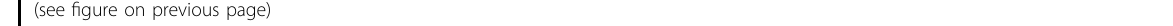
Fig. 6 Defective myotube formation in Nogo-A-silenced C2C12 cells. Expression of Nogo-A in C2C12 myoblast was silenced using si-Nogo-A, and myoblast differentiation was induced by DM for 3 days. A , B qRT-PCR analysis of Nogo isoforms ( A ) and Myod , myogenin, and Myh2 ( B ) in si- scrambled- or si-Nogo-A-transfected C2C12 cells ( n = 3/group). Mean ± SEM. * p < 0.05, ** p < 0.01, *** p < 0.001. C WB of indicated proteins in Nogo-A- silenced cells ( n = 3/group). Molecular weights (kDa) are indicated. D Quantitative assessment of band intensities of WBs in C using the NIH ImageJ software. Mean ± SEM. ** p < 0.01, *** p < 0.001. E IF staining of Nogo-A (green) with DAPI (blue) in differentiated si-scrambled- or si-Nogo-A- transfected C2C12 cells. Scale bar = 20 µm. F Fusion index of differentiated si-scrambled- or si-Nogo-A-transfected C2C12 cells. Fusion index was calculated as the percentage of total nuclei incorporated in myotubes. G Hematoxylin/eosin staining of differentiated si-scrambled- or si-Nogo-A- transfected C2C12 cells. Scale bar = 200 µm. H Quantitative assessment of myo fi ber diameter based on evaluation of 20 diameters in fi ve fi elds per group) in L. Mean ± SEM. * p < 0.05.